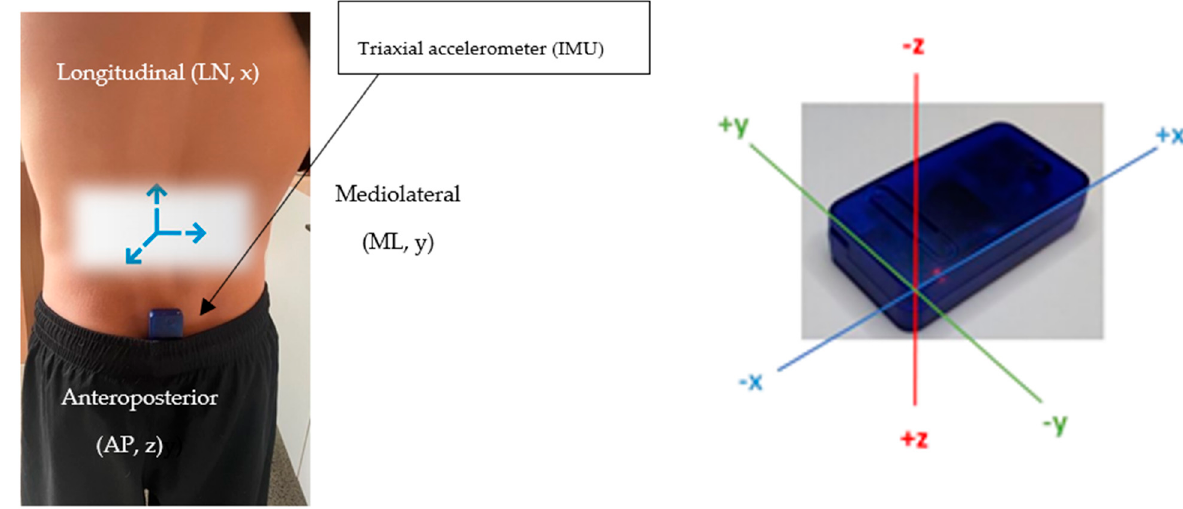
Figure 3. Representation of orthogonal axes orientation and sensor used in study ( left ). Actual sensor used in study ( right ).